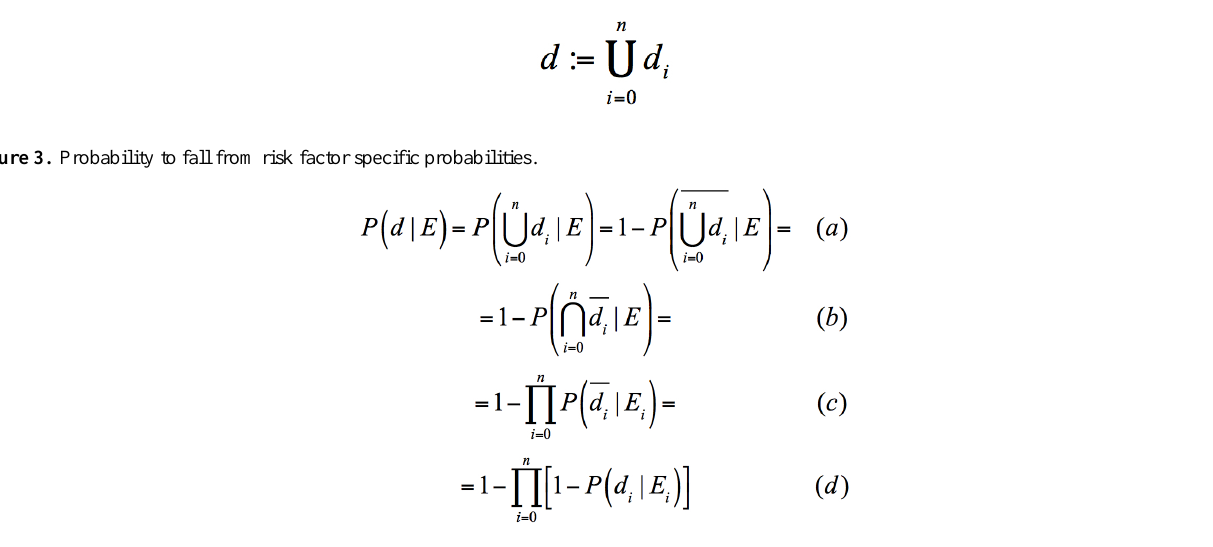
Figure 2. Definition of fall event.